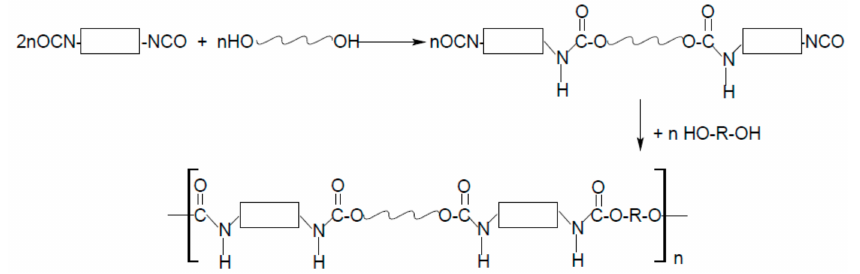
Figure 1. Scheme of polyurethane synthesis based on the example of the prepolymer method.